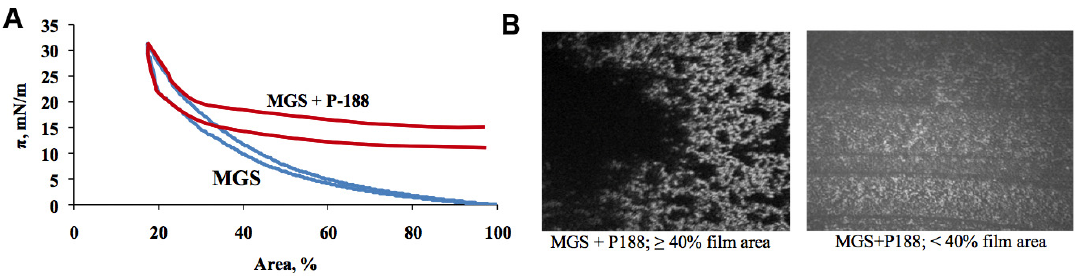
Figure 3. Meibomian gland secretion influenced by P188. Surface pressure/area isotherms of MGS pure and over subphase containing 10 − 6 M P188 ( A ); BAM micrographs (500 × 500 μ m field of view) recorded under the lateral pressure prior to squeezing out of P188 ( B ).